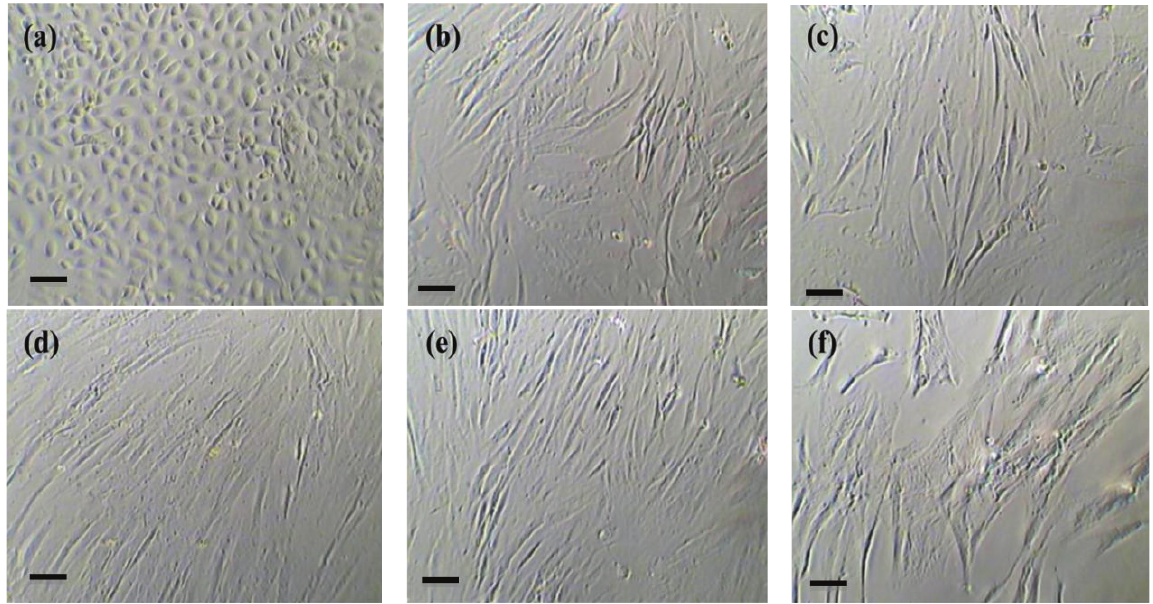
Figure 1: Morphology of cultured mesenchymal stem cells. Representative photomicrographs showing morphology of mesenchymal stem cells at early passage (P3) derived from omentum fat (a), subcutaneous fat (b), and bone marrow (c) and at late passage (P20) derived from omentum fat (d); subcutaneous fat (e) and bone marrow (f), (Scale-20 𝜇 m; Magnification at